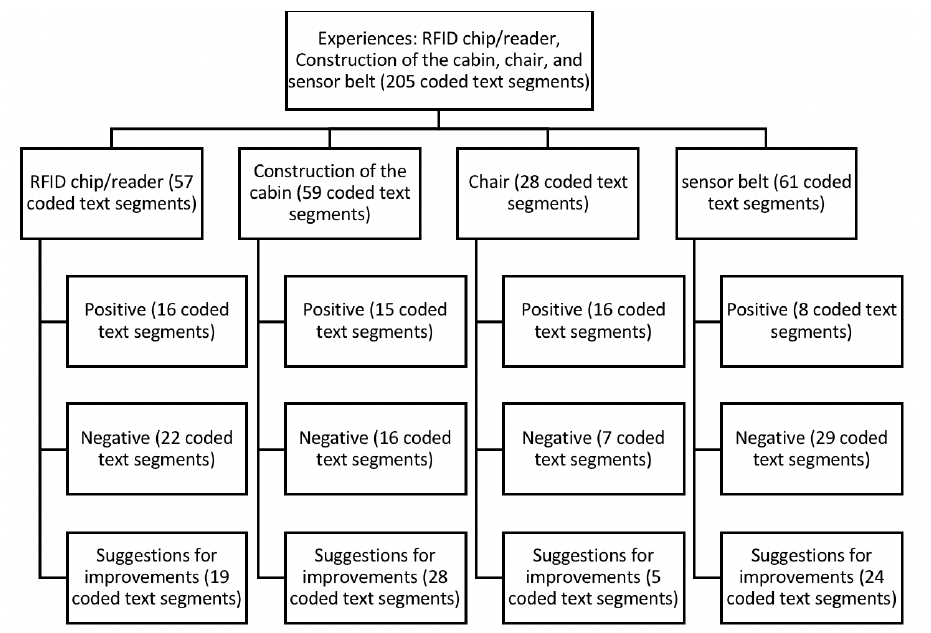
Figure 10. Summary representation of the focus group interviews based on the coded text segments related to RFID chip/reader experiences and construction of the cabin, chair, and sensor